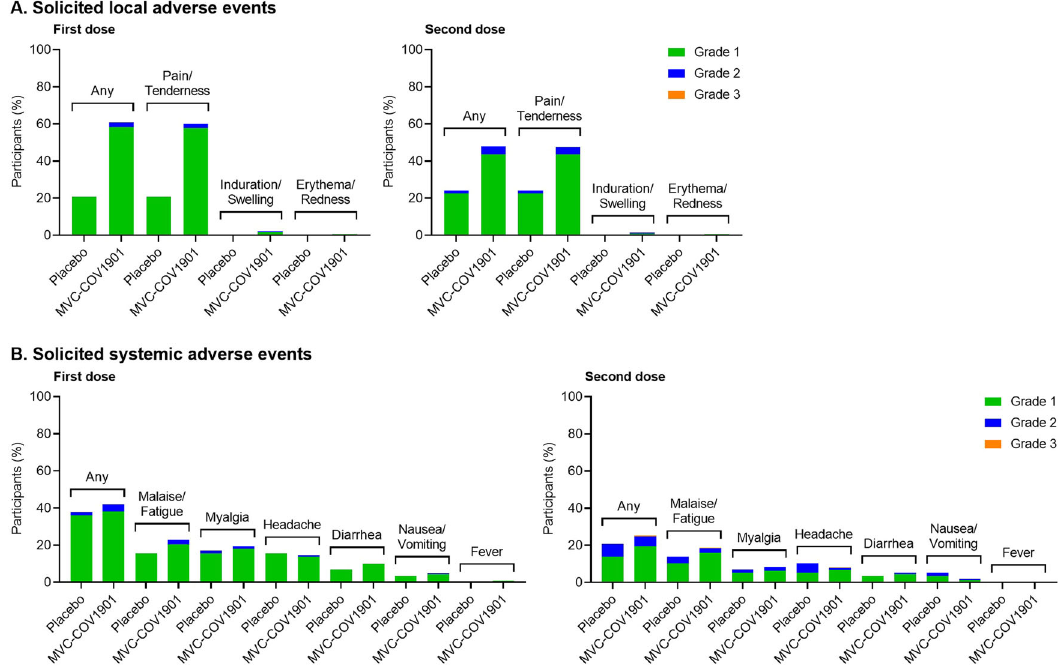
Fig. 2 Adverse events in adolescents after administration of a fi rst or second dose of MVC-COV1901. Solicited local ( A ) and systemic ( B ) adverse events were graded as mild (grade 1), moderate (grade 2), or severe (grade 3).